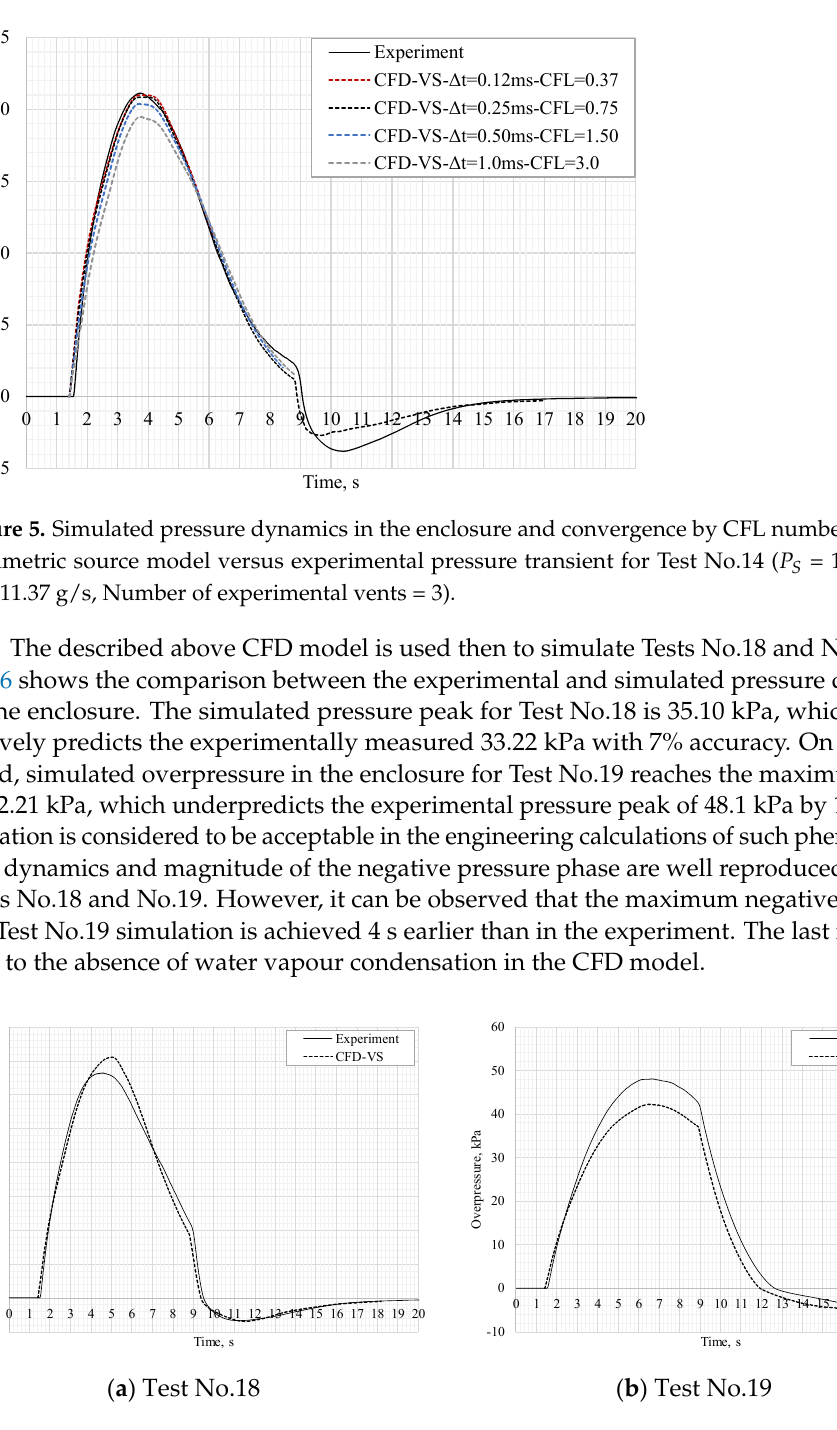
Figure 7. Pressure dynamics in the enclosure for Test No.14 ( 𝑃 (cid:3020) = 11.78 MPa, 𝑚 (cid:4662) = 11.37 g/s, Number of experimental vents = 3): effect of heat transfer to the enclosure walls. 4.2.2. Time-Efficient Approach of the Uniform Cube-Shaped Control Volumes Grid The use of a volumetric source model is found, as demonstrated above, to reduce significantly the calculation time by approximately a factor of 3. In this section, a novel and simplified approach is developed to further enhance the time efficiency of calcula- tions while maintaining an acceptable solution accuracy. This is based on the building of a uniform hexahedral grid throughout the calculation domain with the same size as the vent (7 cm square opening). The volumetric source is modelled as a cube with a 7 cm side. This dimension corresponds to approximately eight times the notional nozzle diameter. The CV number in the domain is 317,878. Maintaining the same CFL = 0.75 at the release